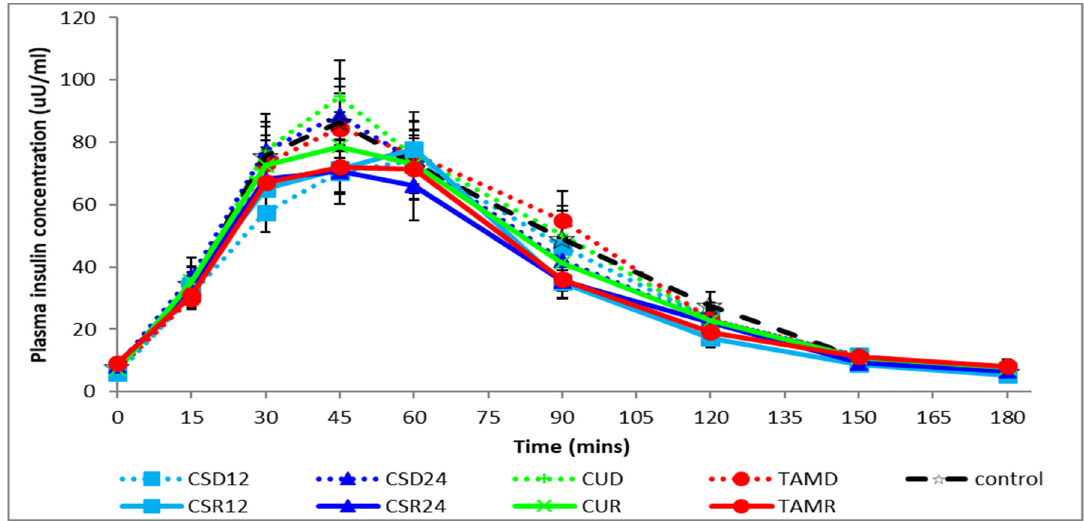
CUD: cumin drink; CUR: cumin rice; TAMD: tamarind drink; TAMR: tamarind rice.